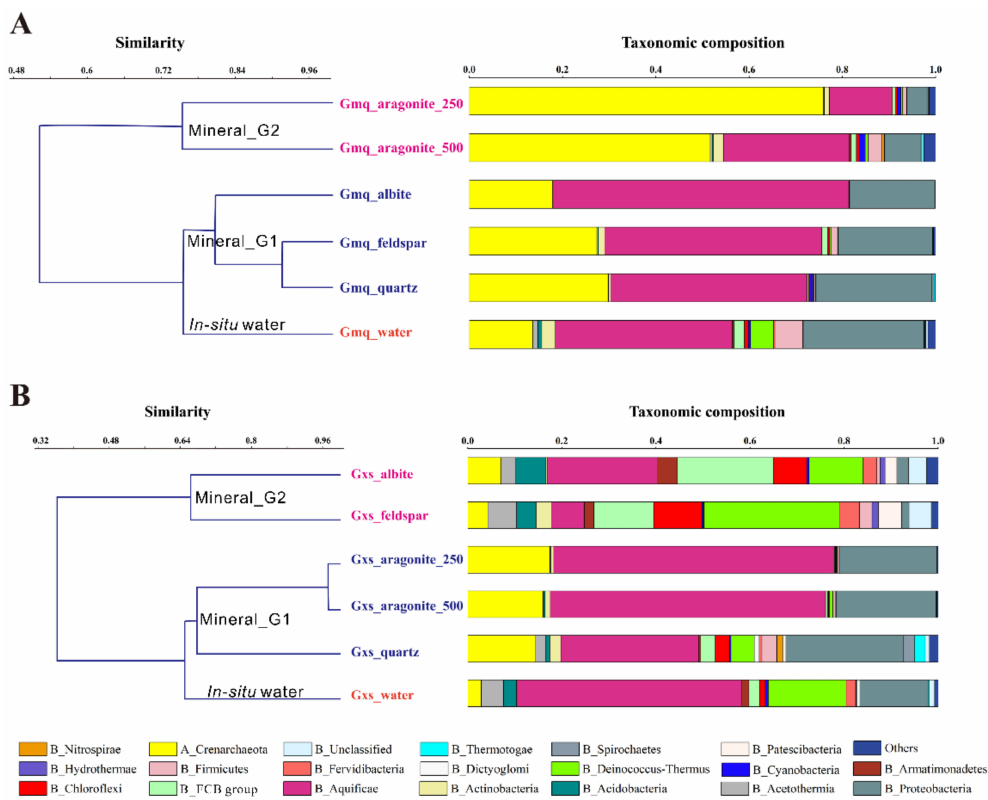
Figure 4. Clusters of community compositions for in-situ water and mineral microcosms in Gmq ( A ) and Gxs ( B ) springs. Clustering the dominant phyla was performed with paired group algorithm based on Bray–Curtis dissimilarity. The sub-clusters separated in the clustering trees were identified as “In-situ water”, “Mineral_G1” and “Mineral_G2” groups. “others” category indicates rarer taxa with relative abundance <1% in each